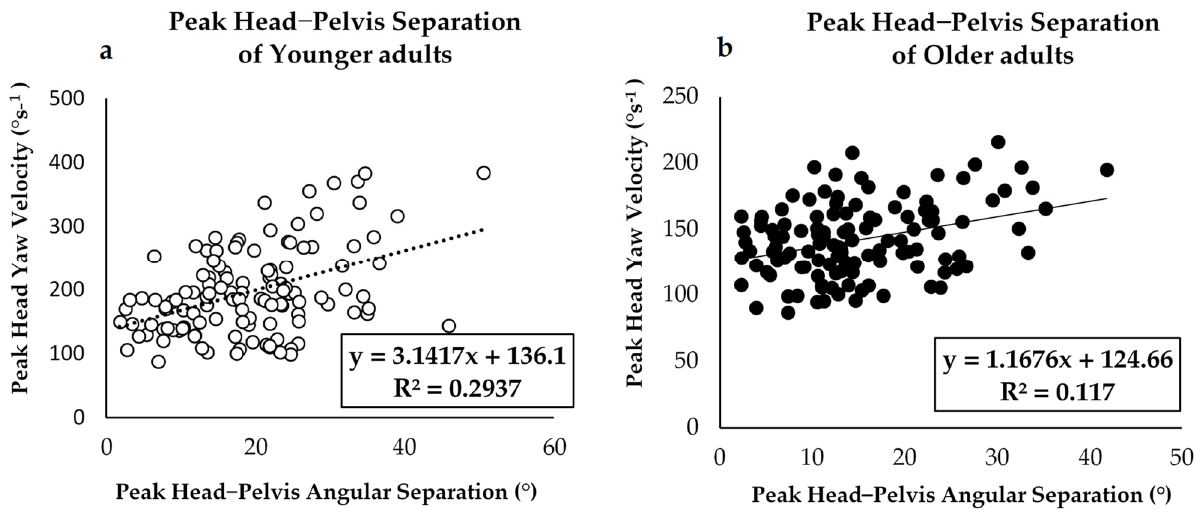
Figure 6. Scatterplot showing the results of regression analyses between peak head yaw velocity and maximum head-pelvis angular separation in ( a ) younger adults group and ( b ) older adults group, a significant positive correlation between peak head yaw velocity and the head-pelvis separation was found between groups ( p < 0.05).